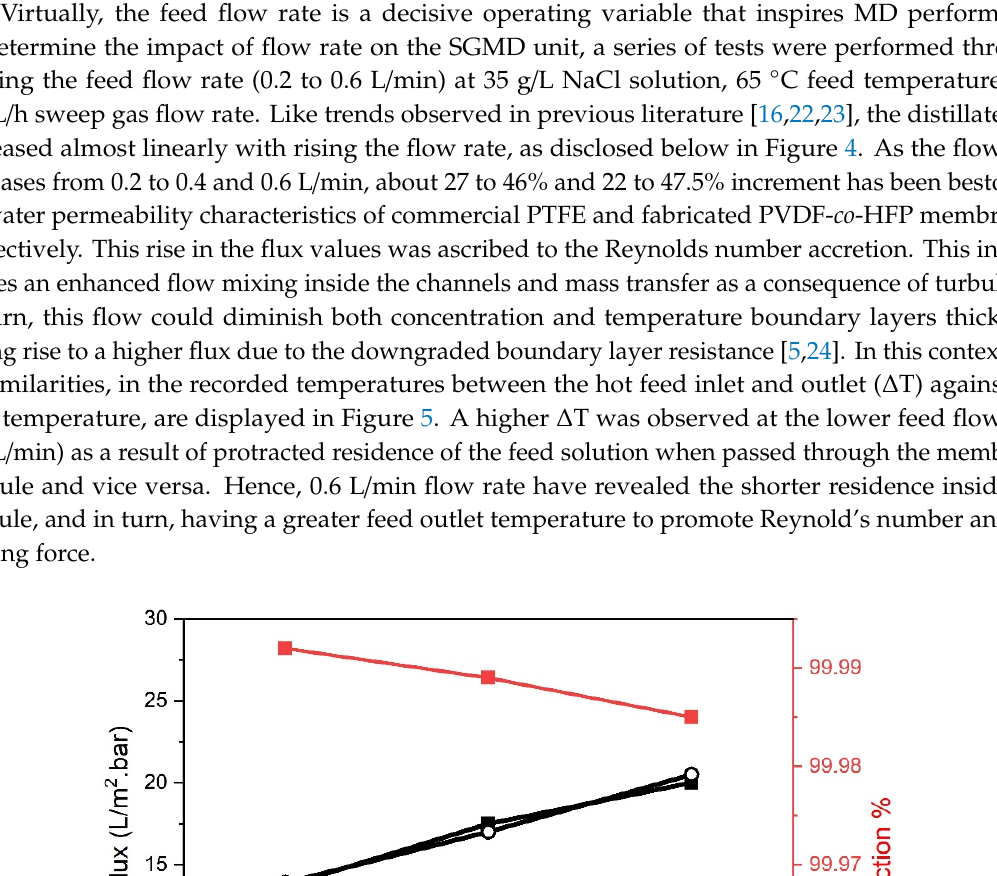
Figure 5. Variance between inlet and outlet feed temperatures versus the inlet feed temperatures for 35 g/L NaCl solution and 300 L/h sweep gas flow rate. 3.2.3. Influent of Feed Concentration Similar to other membrane separation processes, all MD configurations are oversensitive to the feed concentration [26]. Unlike feed concentrations (35, 70 and 100 g/L) at 0.6 L/min feed flow rate, 300 L/h sweeping gas flow rate and 65 °C feed temperature were harnessed during the experiments. As depicted in Figure 6 below, the results manifested that distillate flux decreases upon increased concentrations. About 18.7% permeate flux reduction, for the PVDF- co -HFP membrane, was recorded when rejecting 35 g/L NaCl feed solution. Further straightforward flux decline by 24% and